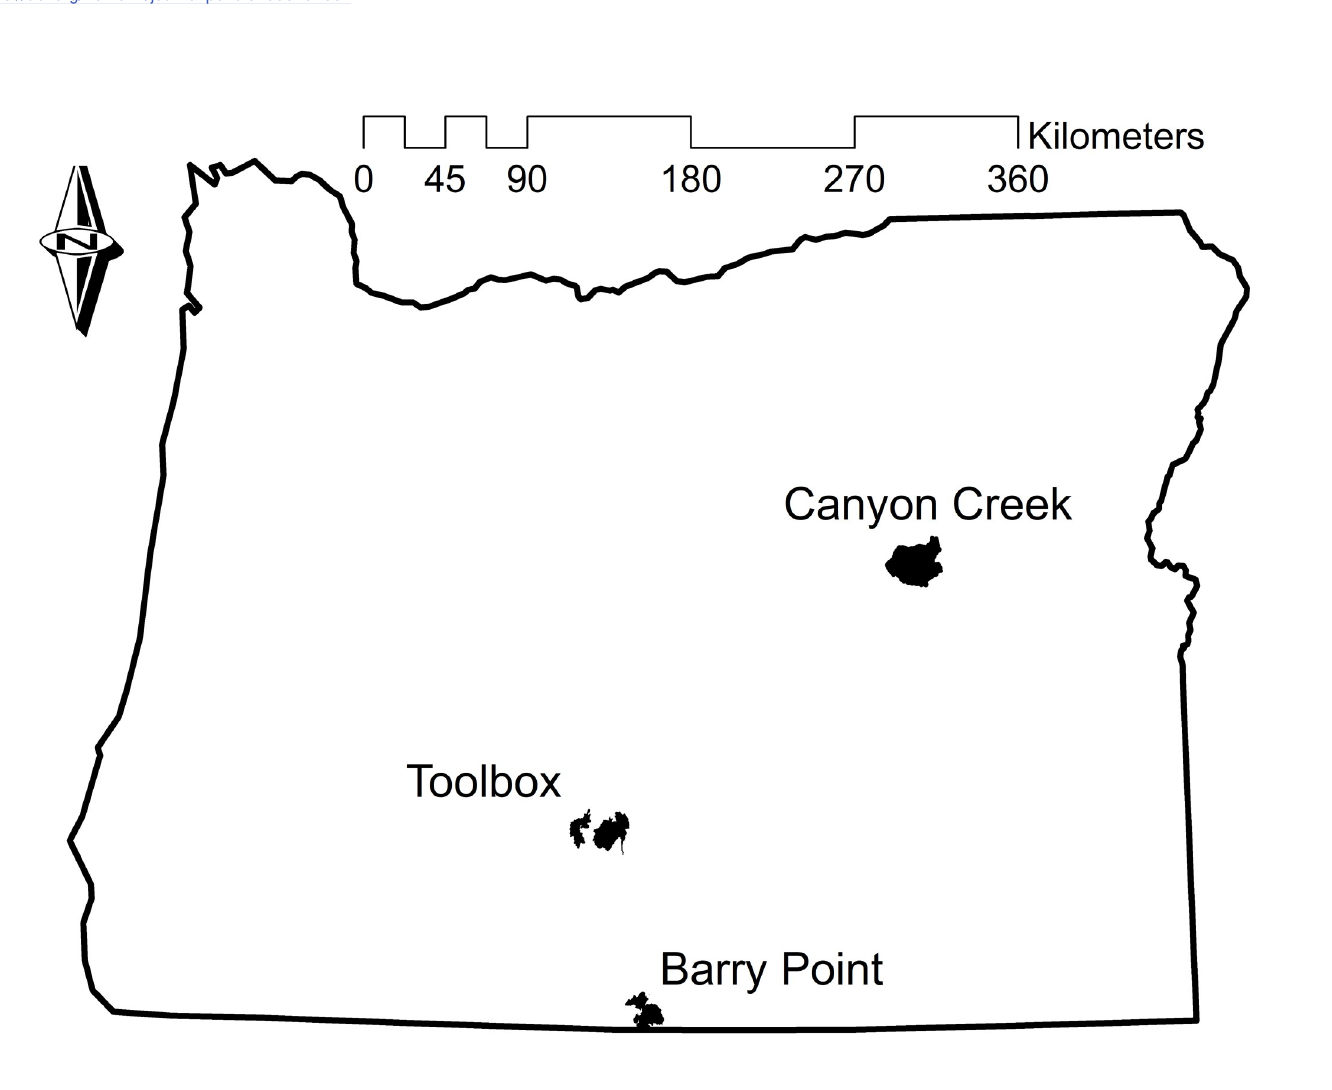
Fig 1. Wildfire locations. Maps showing the three study locations where habitat suitability models were developed and evaluated for white-headed woodpeckers in burned forests, Oregon, U.S.A.